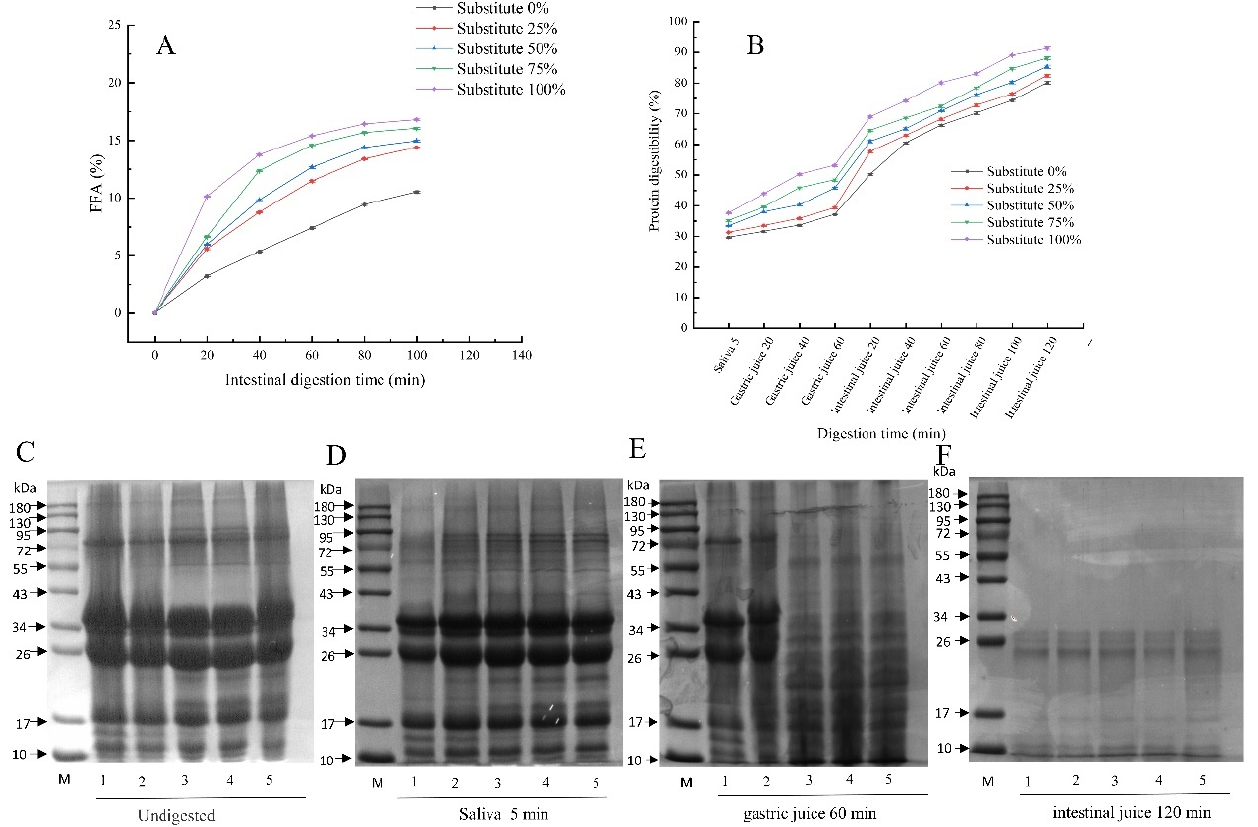
Figure 5. Effects of replacing milk fat with SOBs on the digestive characteristics of yogurt. Note: ( A ) Free fatty acids, ( B ) protein digestibility, ( C ) undigested, ( D ) saliva for 5 min, ( E ) artificial gastric juice digestion for 60 min, ( F ) artificial intestinal juice digestion for 120 min. M: Marker; Lanes 1–5 respectively represent substitution amount 0%, substitution amount 25%, substitution amount 50%, substitution amount 75%, substitution amount 100%.